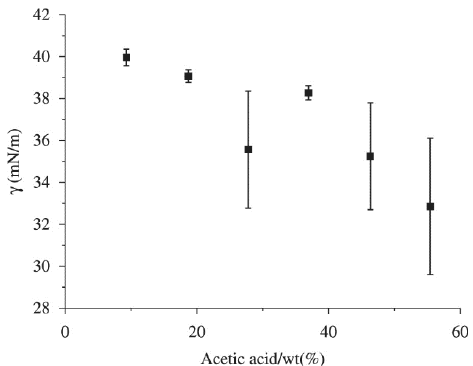
Figure 3. Surface tension as a function of acetic acid concentration in gelatin/PVP